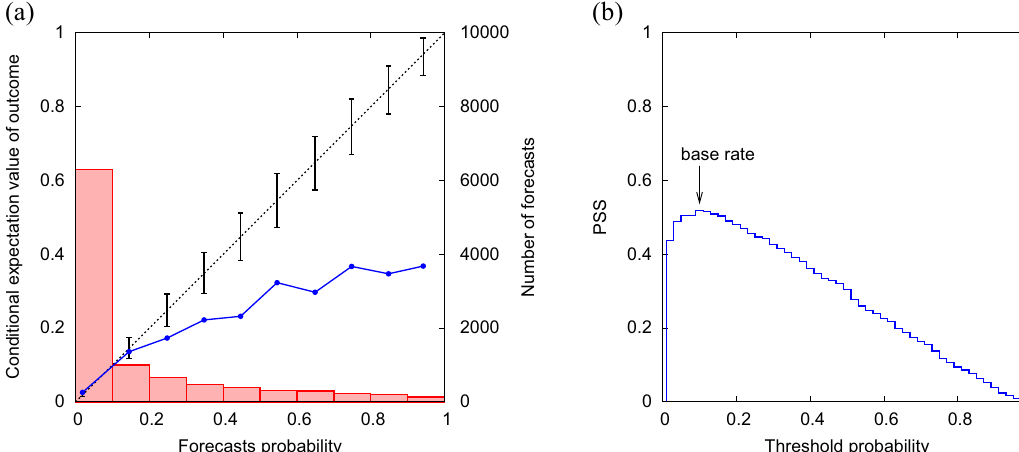
Fig. 3. Same as Figure 1, but for case 3. (a) Reliability diagram for case 3. (b) PSS versus threshold probability for case 3.